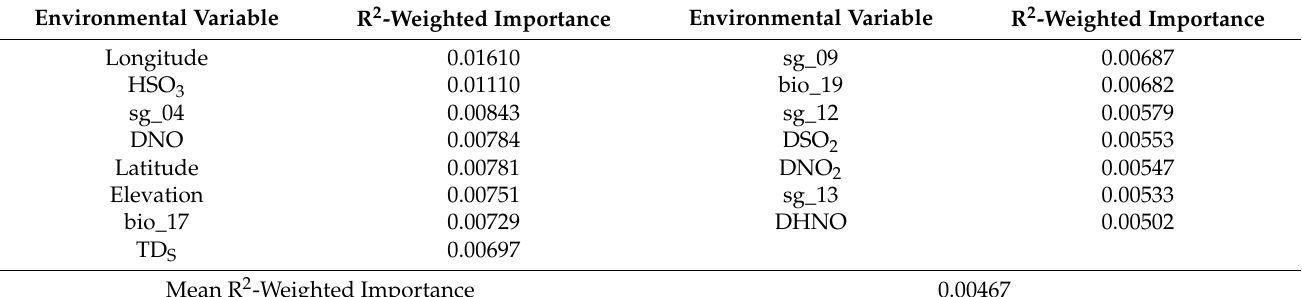
Table 4. R 2 -weighted importance values for top 15 environmental variables in decreasing order (left and right column) with mean R 2 -weighted importance of all environmental variables. R 2 -weighted importance values are the average of all R 2 S performance values for all species for each given